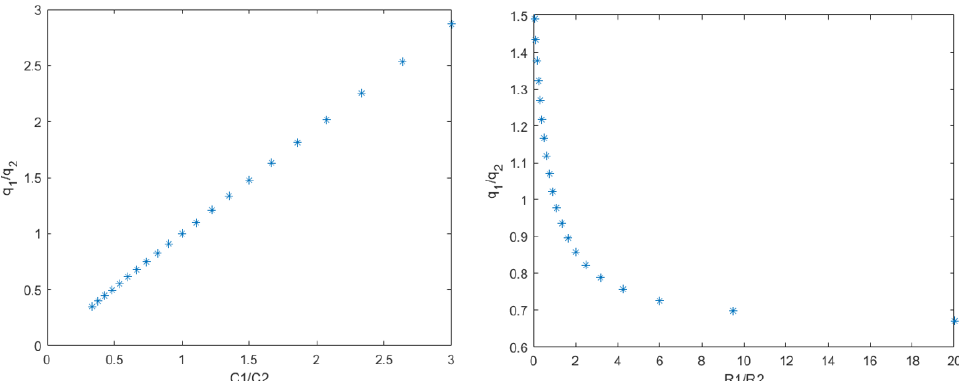
Figure 4. Influence factors of charge flow conditions.